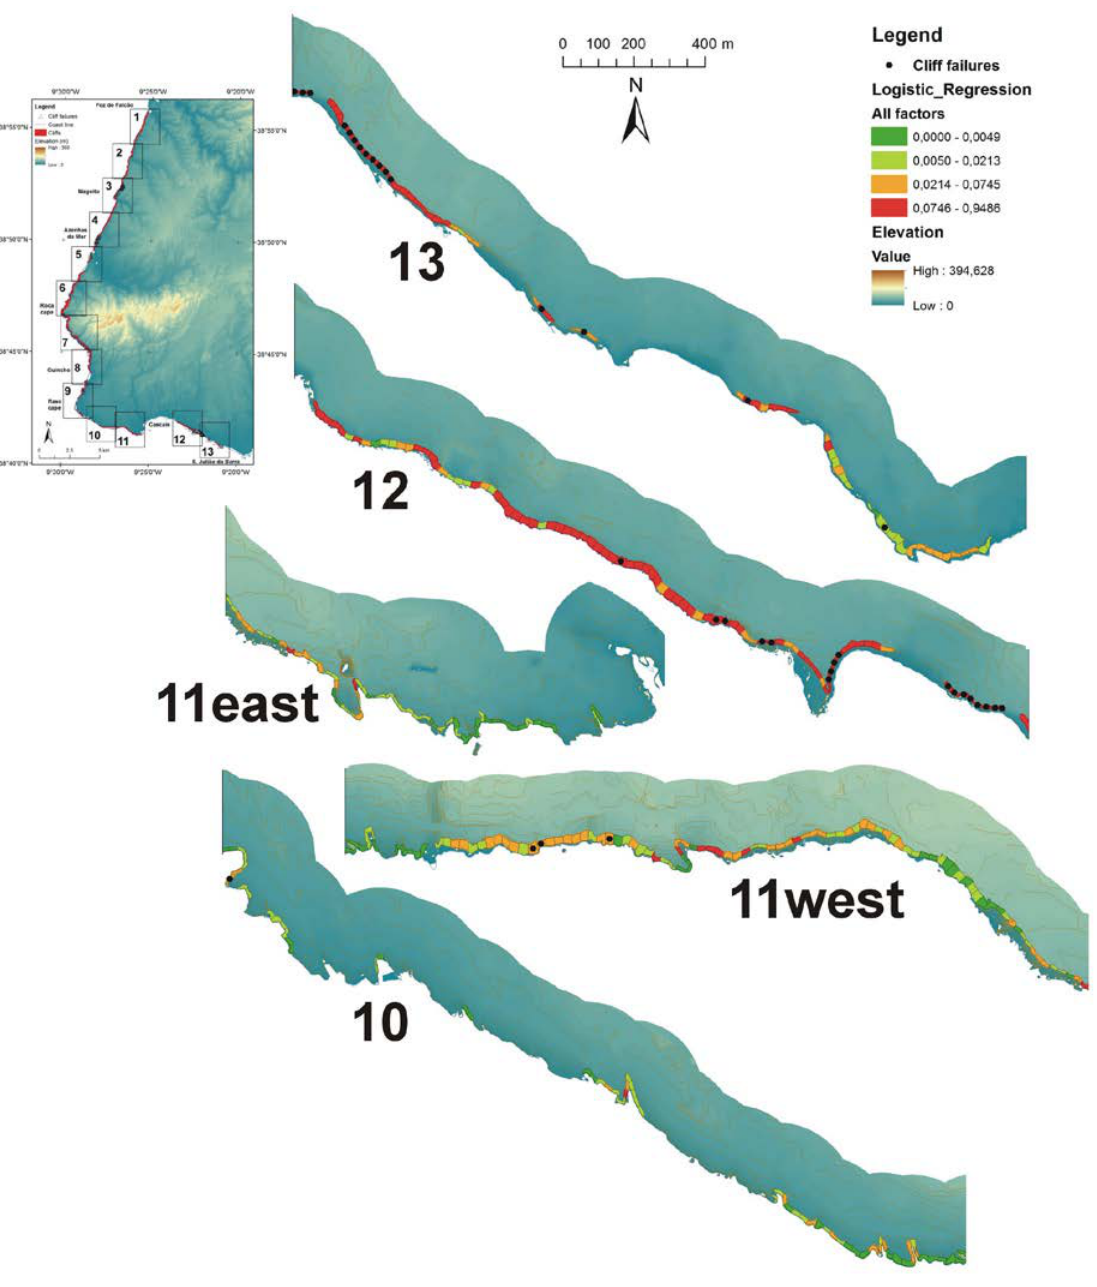
Figure 9. Susceptibility mapping (4/4) for cliff sections 10 to 13 (legend as Figure 7).